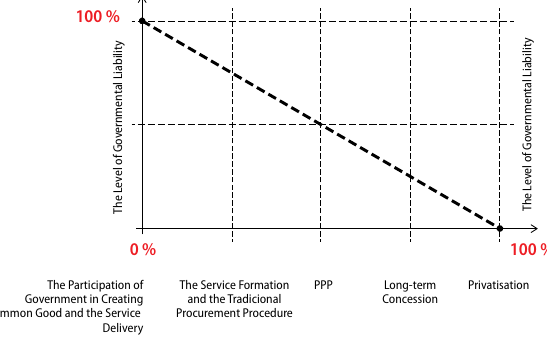
fig. 1. The relationship between the distribution of responsi- bility and risk-sharing and the choice of the partnership model